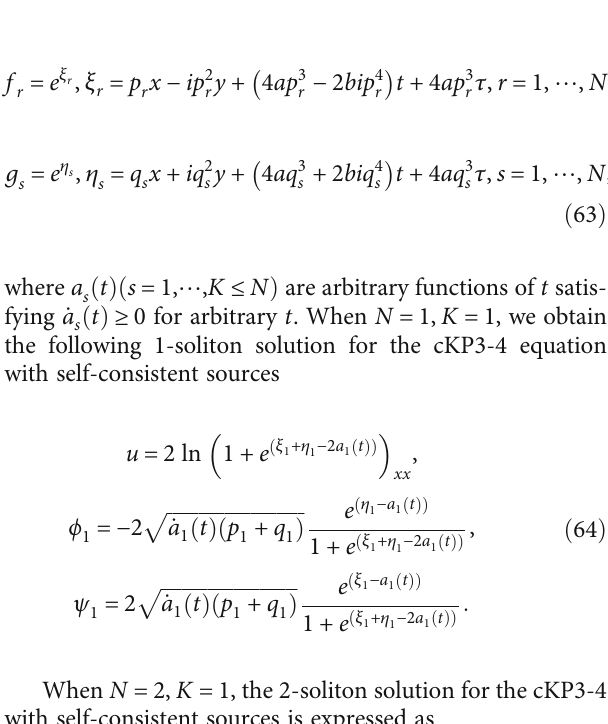
Figure 9: The semirational solution u = 2 ln ð G Þ , where G is given by (40) with p 1 = 1/2 , q 1 = 1/2 , p 2 = 1/2 , q 2 = 1/2 , c 10 = d 10 = 1 , c 11 = xx d 11 = 0 , a = 1 , b = 1 , ξ 10 = η 10 = 2 π , ξ 20 = η 20 = − 2 π , C 11 = C 22 = 1 , C 12 = C 21 = 0 : (a) t = − 25 , (b) t = − 12 , (c) t = − 6 , (d) t = 0 , (e) t = 6 , (f) t = 12 , and (g) t = 25